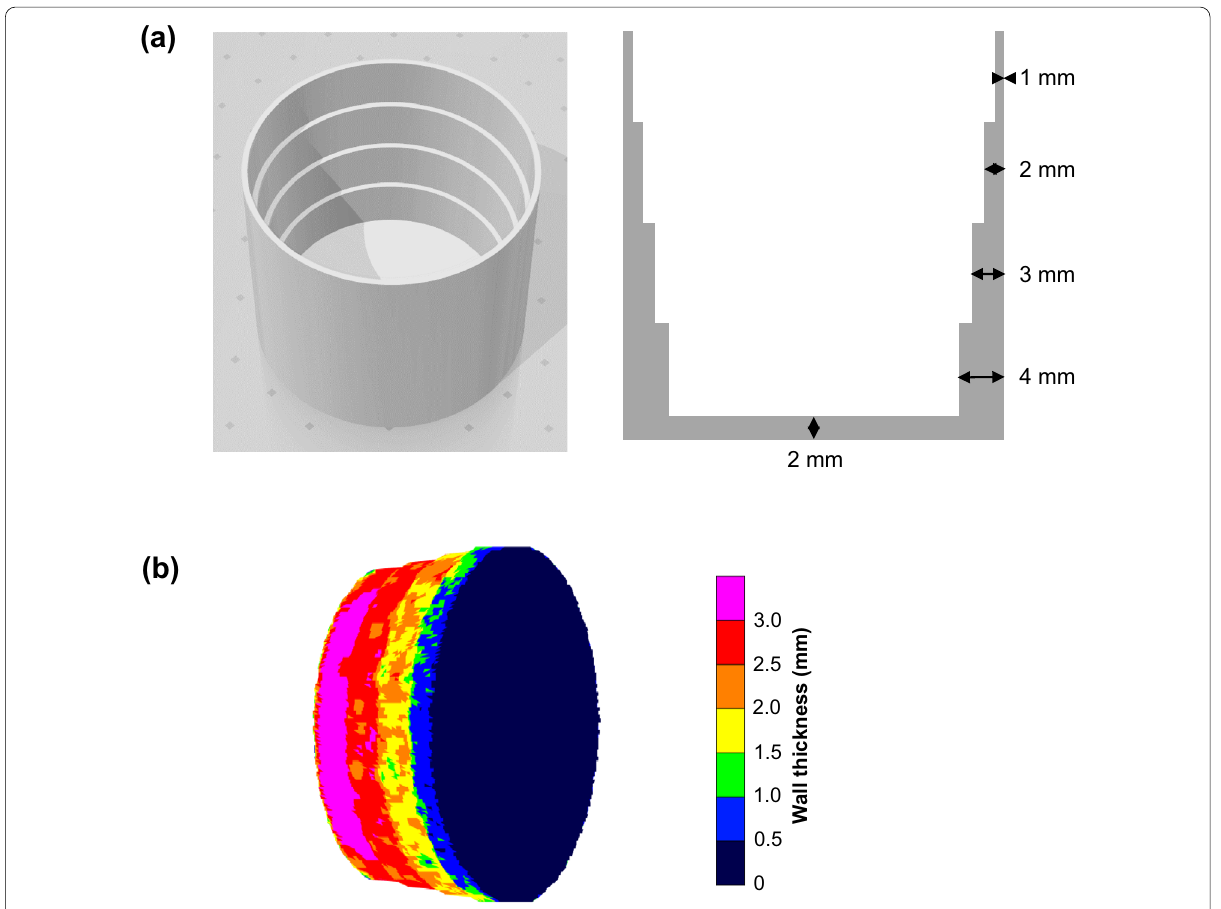
Fig. 1 Chamber phantom and its 3D wall thickness map. a Diagram of the model used in the present study. The 3D figure was generated by Inventor 2019 (Autodesk, San Rafael, CA) and the cross‑sectional diagram was generated by PowerPoint 2016 (Microsoft, Redmond, WA). b 3D wall thickness map showed distinct regions with thickness of 1, 2, 3, and 4